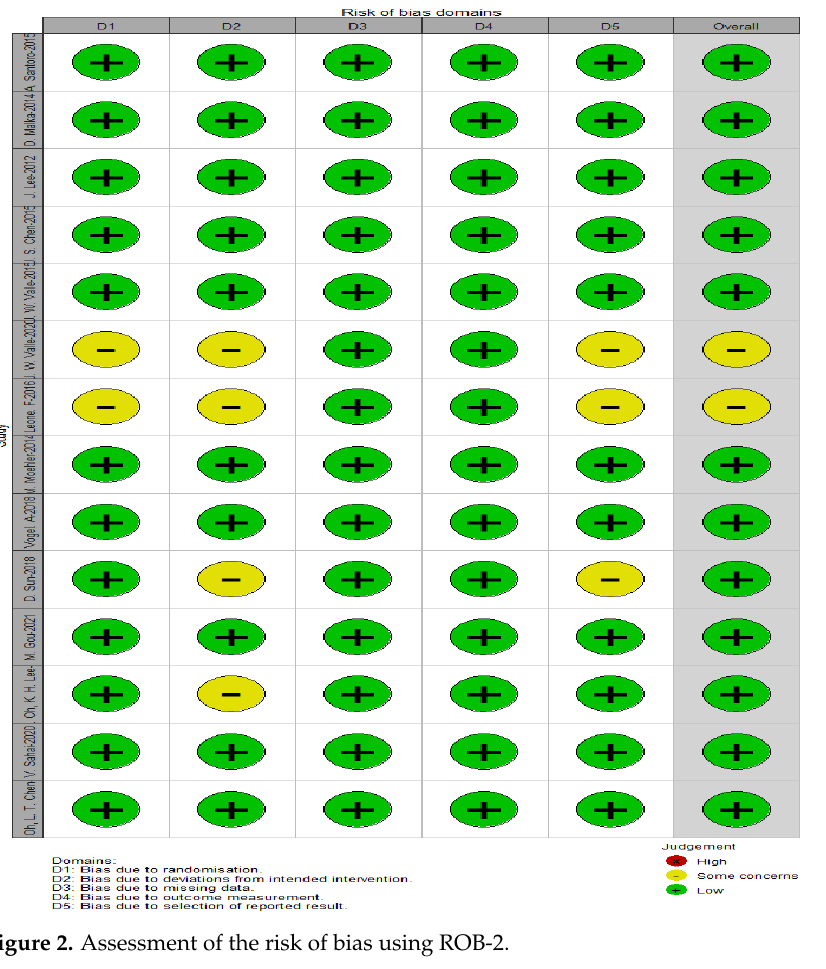
Figure 2. Assessment of the risk of bias using ROB - 2.